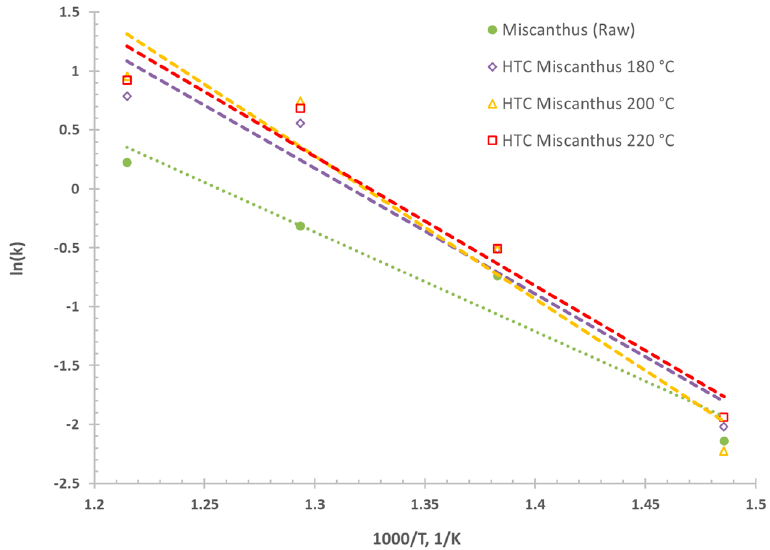
Figure 10. Arrhenius plot for pyrolysis of Miscanthus—influence of HTC (dotted lines are trend lines).